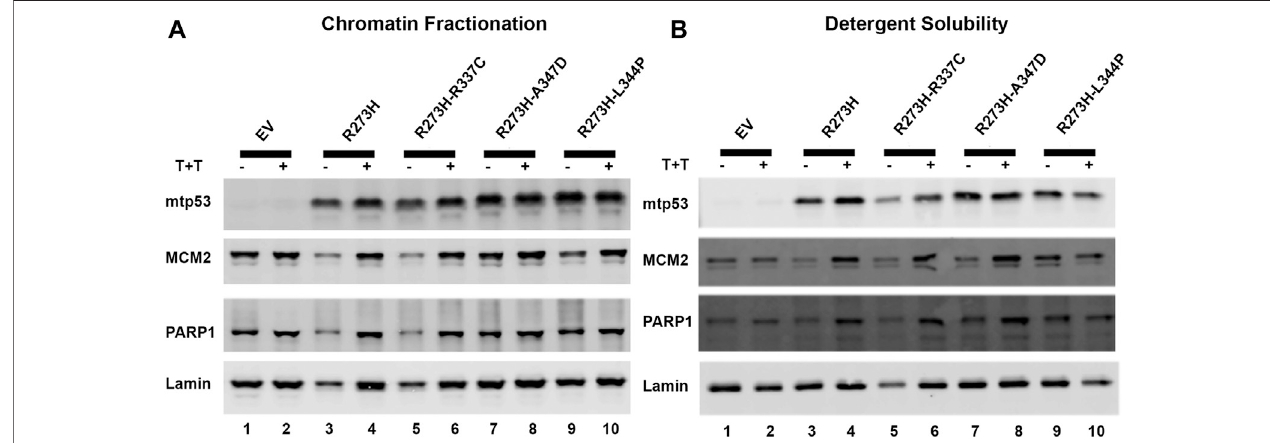
FIGURE 3 | Destabilizing oligomerization of mtp53 R273H does not block the interaction with chromatin. The chromatin fractionation and the detergent solubility assays were used to fractionate lysates prepared from HCT116 p53 − / − cells transfected with mtp53 R273H, or dual mutants R273H-R337C, R273H-A347D, or R273H-L344P into cytosolic/soluble fraction and chromatin/insoluble fraction. Analysis of lysates from cells without drug treatment (lanes 1,3,5,7,9) or with a combination oftemozolomide (T) at 1 mmol/L plus talazoparib (T) at 10 μ mol/L for 4 h (lanes 2,4,6,8,10) was carried out. Binding of mtp53, MCM2, and PARP1 to chromatin isolated from partially puri fi ed lysed nuclei (chromatin fractionation assay) or high detergent total cell lysates (detergent solubility assay) was assessed by western blot analysis. 25 μ g of chromatin protein was loaded on 10% SDS-PAGE gel. (A) Western blot depicting the chromatin association of p53, MCM2, and PARP1 after chromatin fractionation. (B) Westernblot analysis depicting the chromatin associationof p53, MCM2, and PARP1 after detergent solubility. The protein expression levelofeachtargetproteinwasnormalizedtolamin.Thedatarepresentanaverageofthreeindependentbiologicalreplicates.ImageJquanti fi cationofproteinexpression level is represented in Supplementary Figures S3A,B